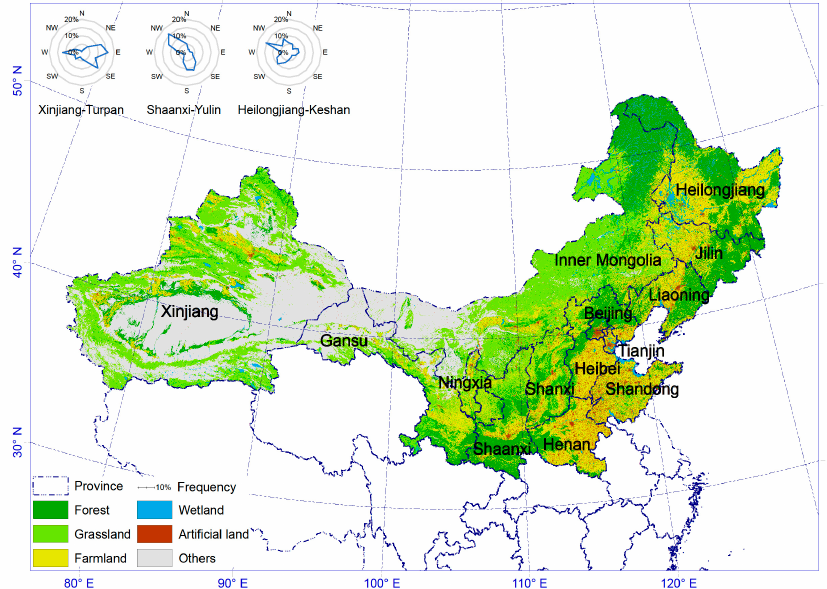
Figure 1. Land use diagram of the study area (GCS: WGS84). The subgraphs illustrate the wind rose (direction frequency, %) in typical western (Xinjiang–Turpan), middle (Shaanxi–Yulin) and eastern (Heilongjiang–Keshan) stations, respectively.